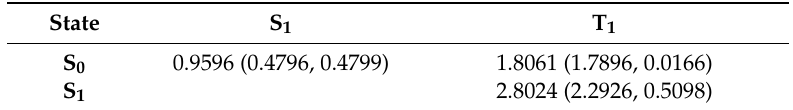
Table 7. Similarity indices d AB calculated at the CASSCF(22,16) / cc-pVTZ level for low-lying electronic states of S 2 N 2 . Values in brackets are ( π -only, σ -only) valence contributions to the total